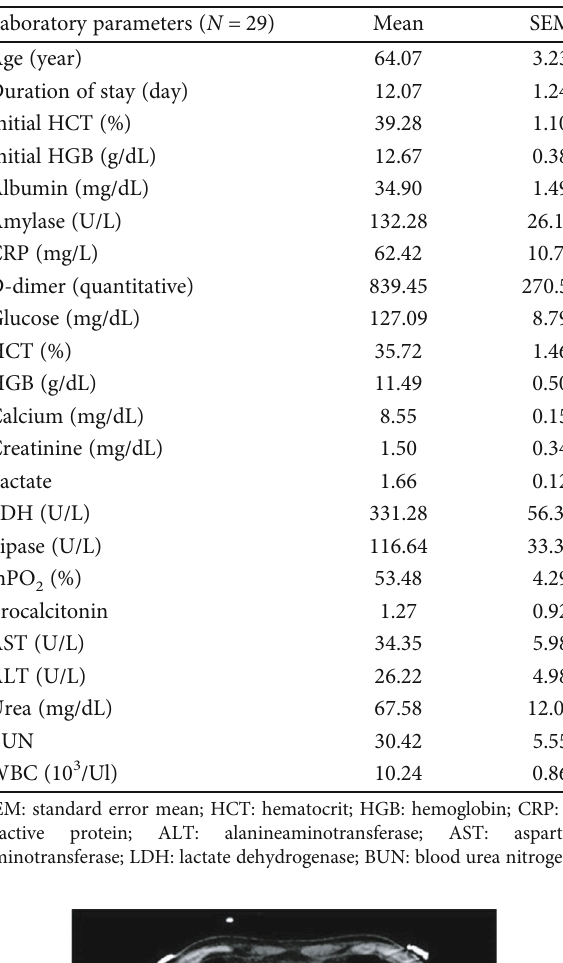
Table 2: Lung CT and clinical scores of patients with COVID-19 and acute